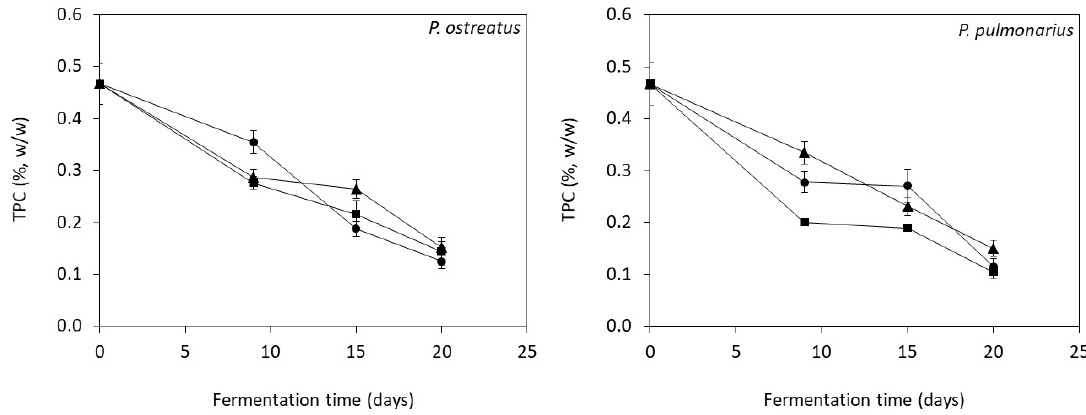
Figure 1. Total phenolic content (TPC) of the colonized substrate during solid-state (SSF, ● ), submerged (SmF, ▲ ) and semiliquid (SLF, ■ ) fermentations of P. ostreatus and P. pulmonarius using grape pomace as substrate.